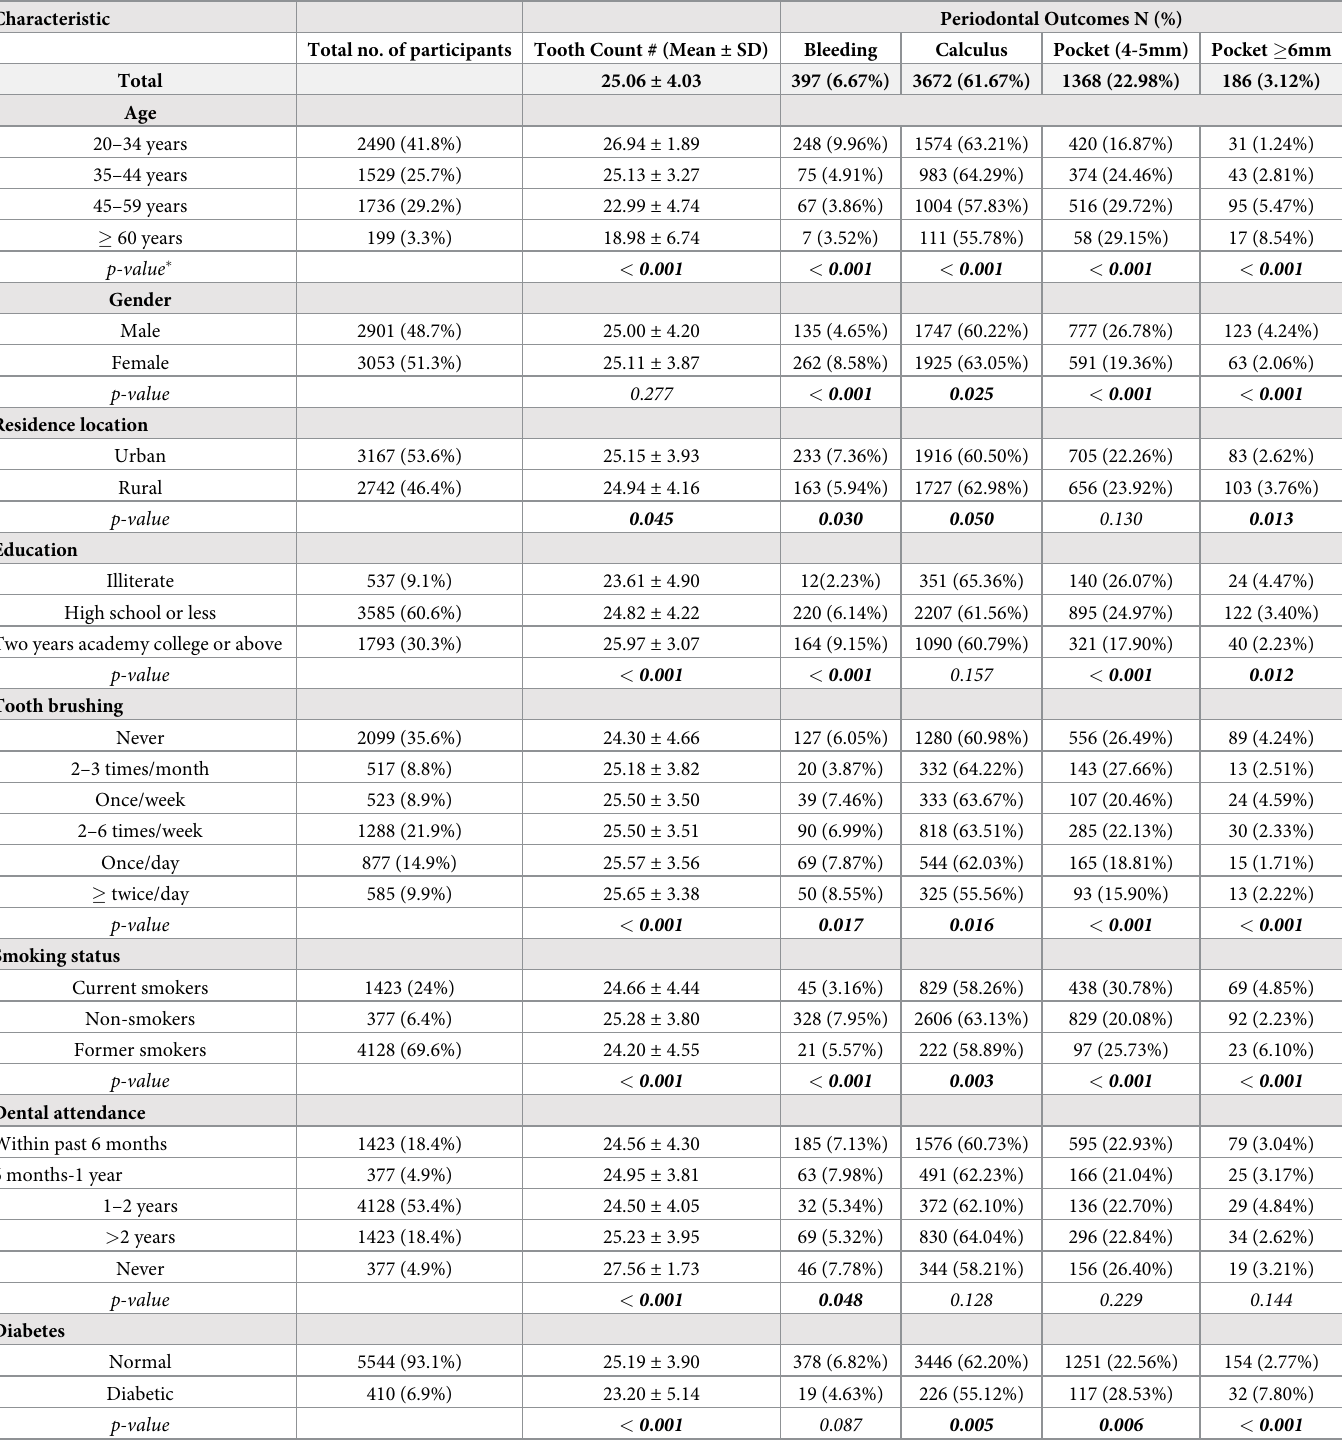
Table 1. Socio-demographic characteristics of study participants and the distribution of the periodontal outcomes within the study variables.